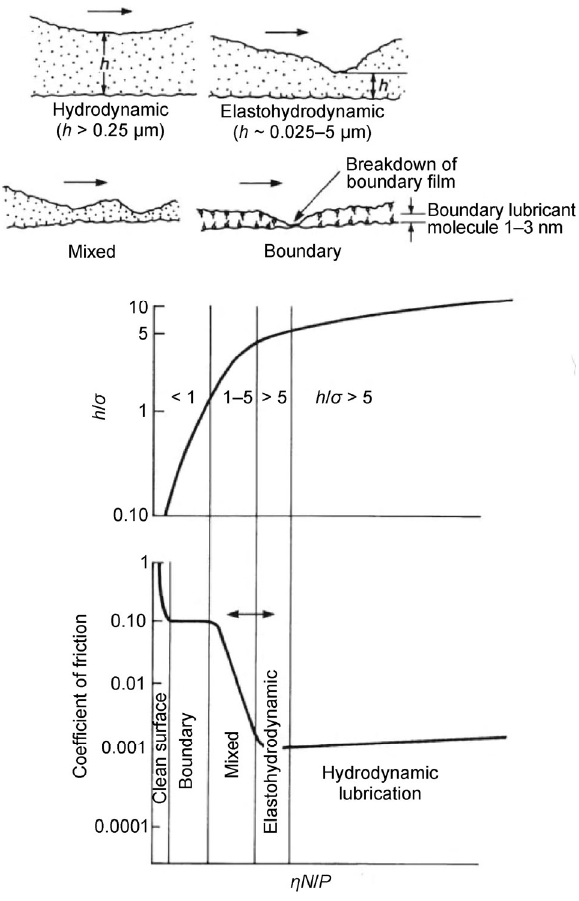
Fig. 2 Lubrication map defined by using only h / R a (or h / σ ) [36]. Copyright 2013, John Wiley and Sons. Fig. 3 Lubrication map proposed by Luo et al.